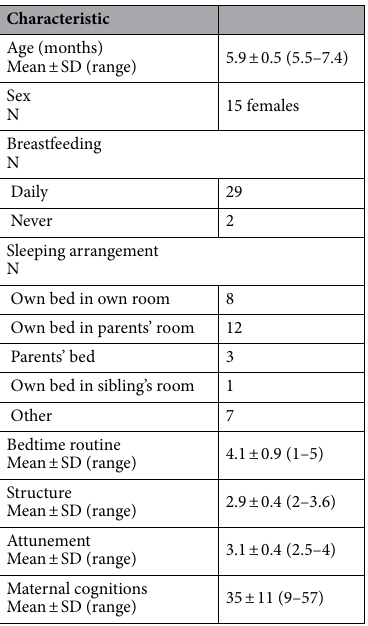
Table 1. Characteristics of the participants shown as the mean, the standard deviation (SD) and the range (minimum-maximum), or the number (N) across 31 infants. The bedtime routine was rated from 1 to 5 with higher scores representing more regularity. Structure and attunement were rated on a 4-point scale ranging from “strongly disagree” (1) to “strongly agree” (4). Maternal cognitions are represented as the total score of subscale composite scores as described in the original publication 41 with higher scores indicating greater maternal anxiety and concerns about the infant’s sleep.